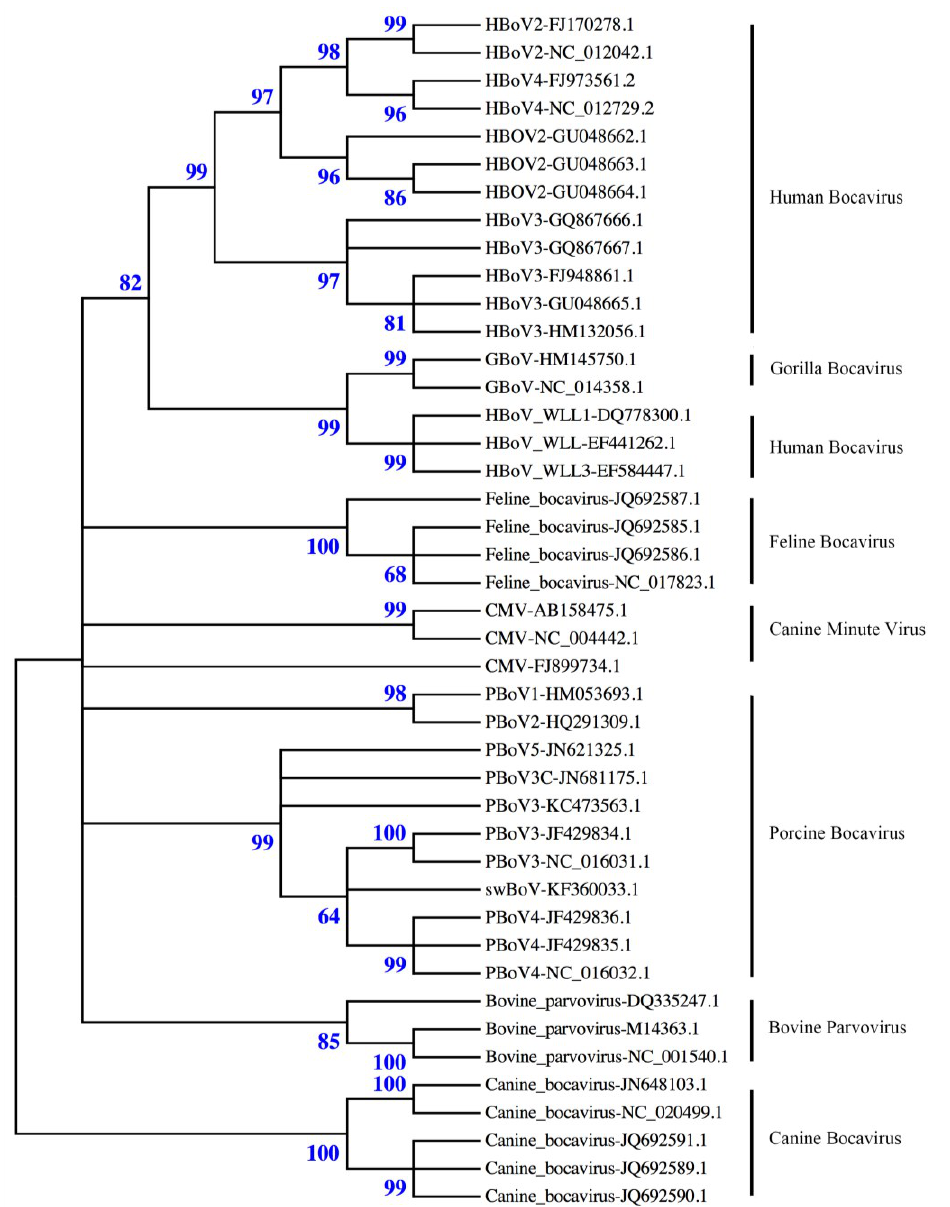
Figure 1. Phylogenetic analysis of bocaviruses. The phylogenetic tree was constructed using nearly full-length nucleotide sequences from bocaviruses in GenBank using the MEGA 5.2 software package [31] (neighbor-joining method with 1000 bootstrap